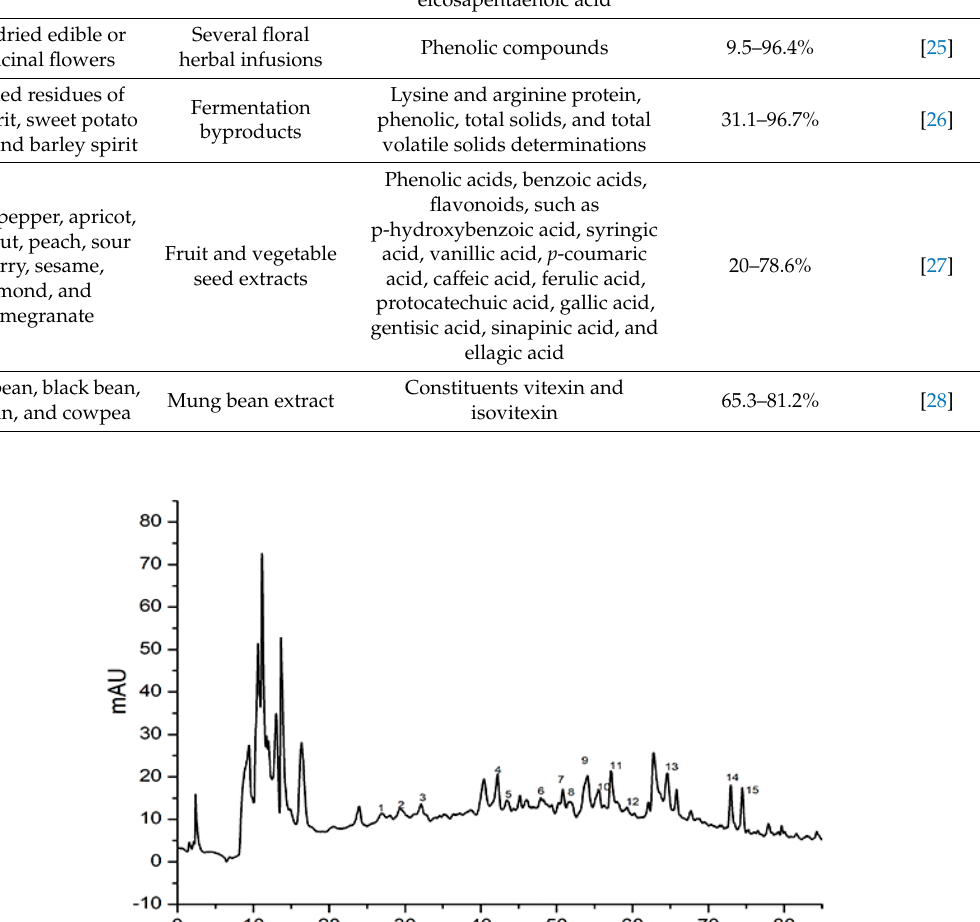
Table 1. Summary of literature reports on CML inhibition by different substances.